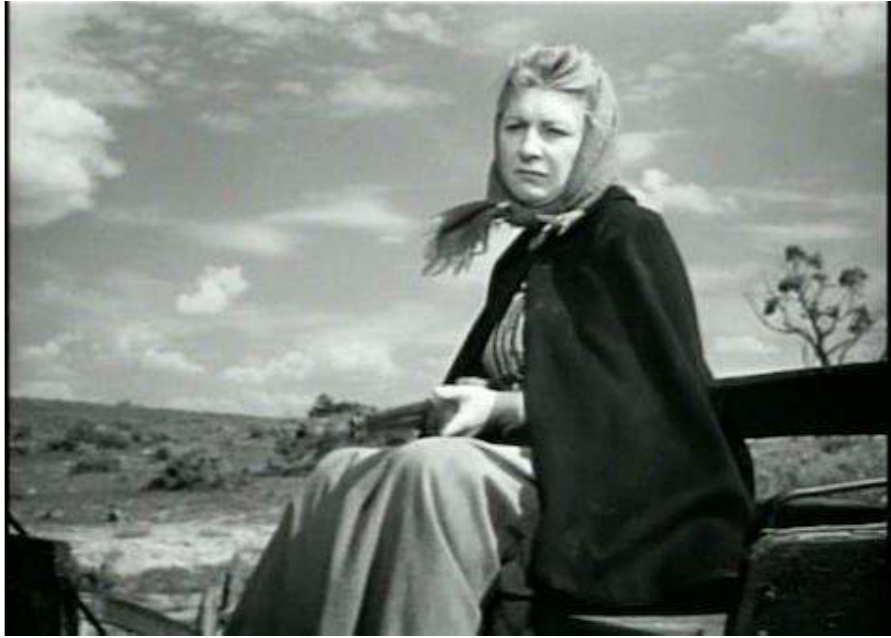
Colorado Territory : The South versus the